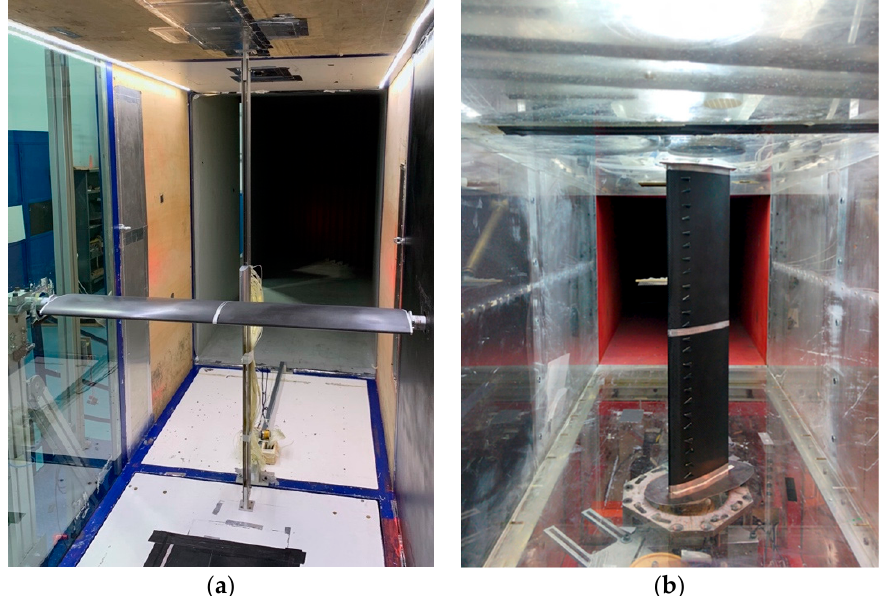
Figure 4. Two-dimensional sectional model tests of the SG6040 airfoil ( a ) and of the SD7032 ( b ). In both models, the pressure loop is seen at the midspan and the wake rake downstream of the test section.